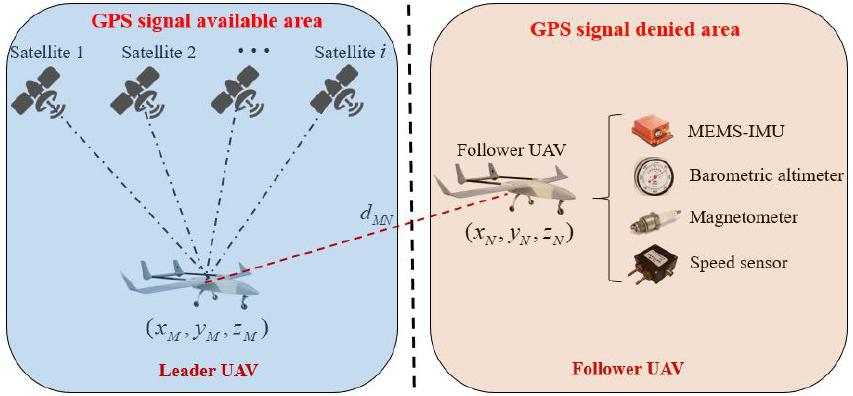
Figure 1. A known position leader UAV and an unknown position follower UAV cooperative localization scenario based on relative ranging.